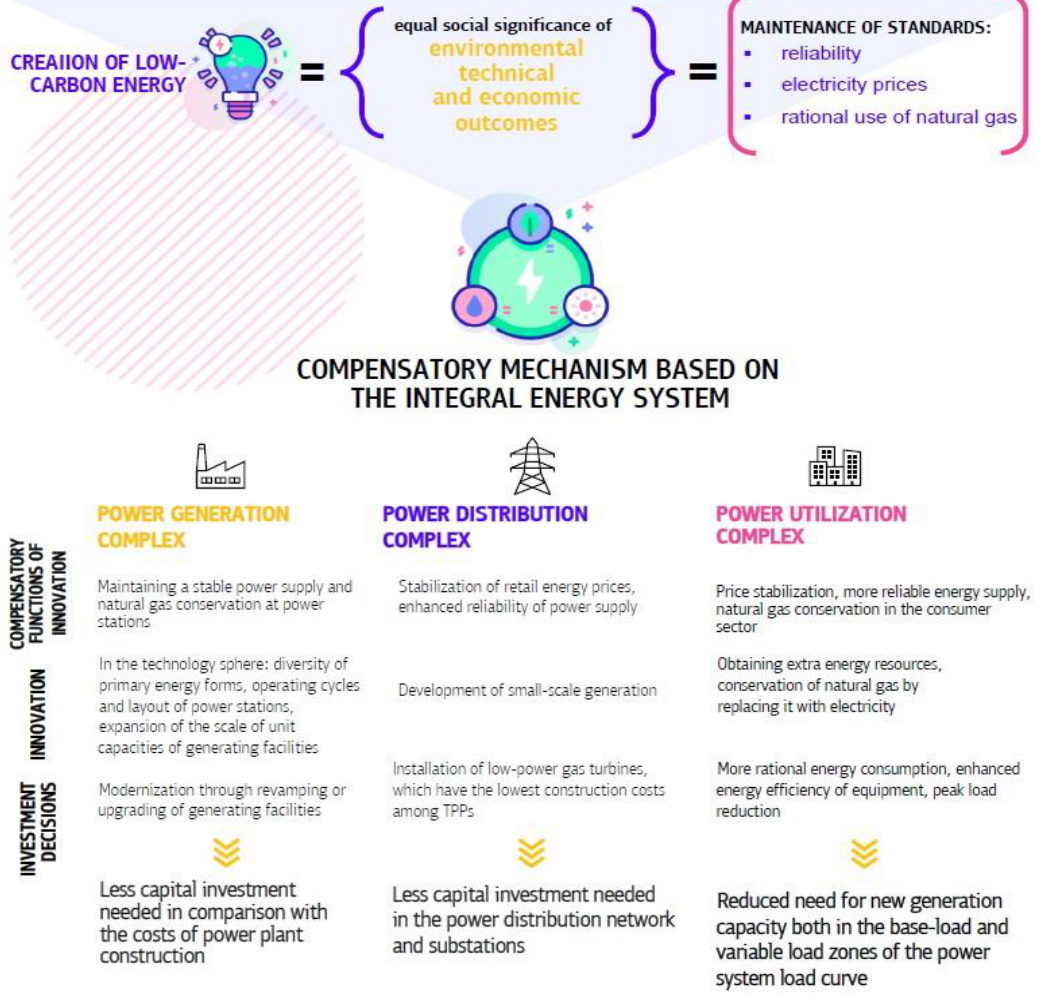
Figure 1. Hypothesis visualization.